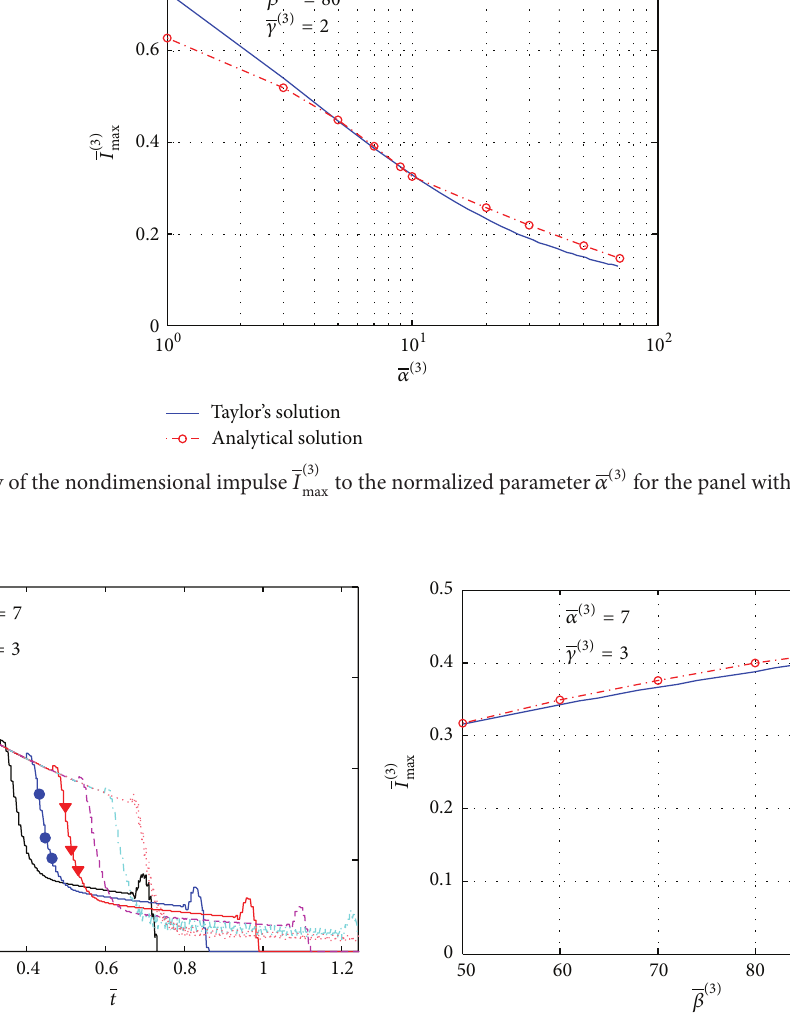
Figure 21: (a) The normalized time histories of the nondimensional pressure 𝑝 𝛽 (3) . (b) Sensitivity of the nondimensional impulse 𝐼 (3)